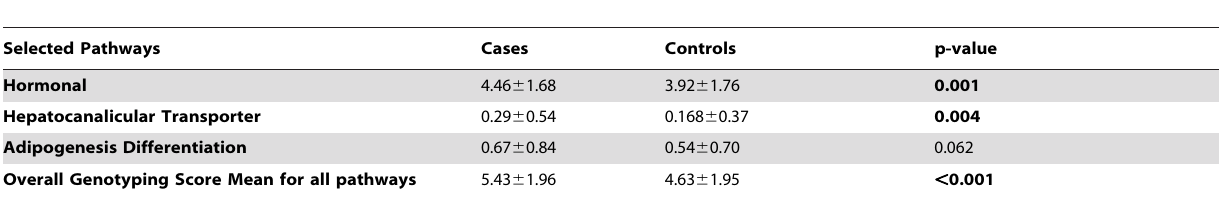
Table 5. Mean G-Scores in the Selected Pathway and their Corresponding p-values.